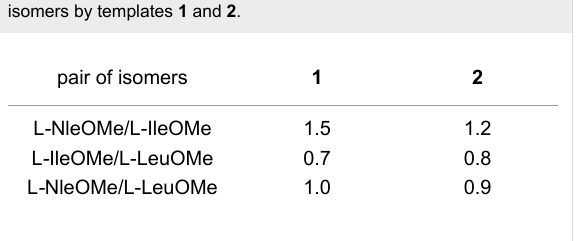
Table 1: ILGM ratios for the recognition of the three pairs of L-leucine isomers by templates 1 and 2 .